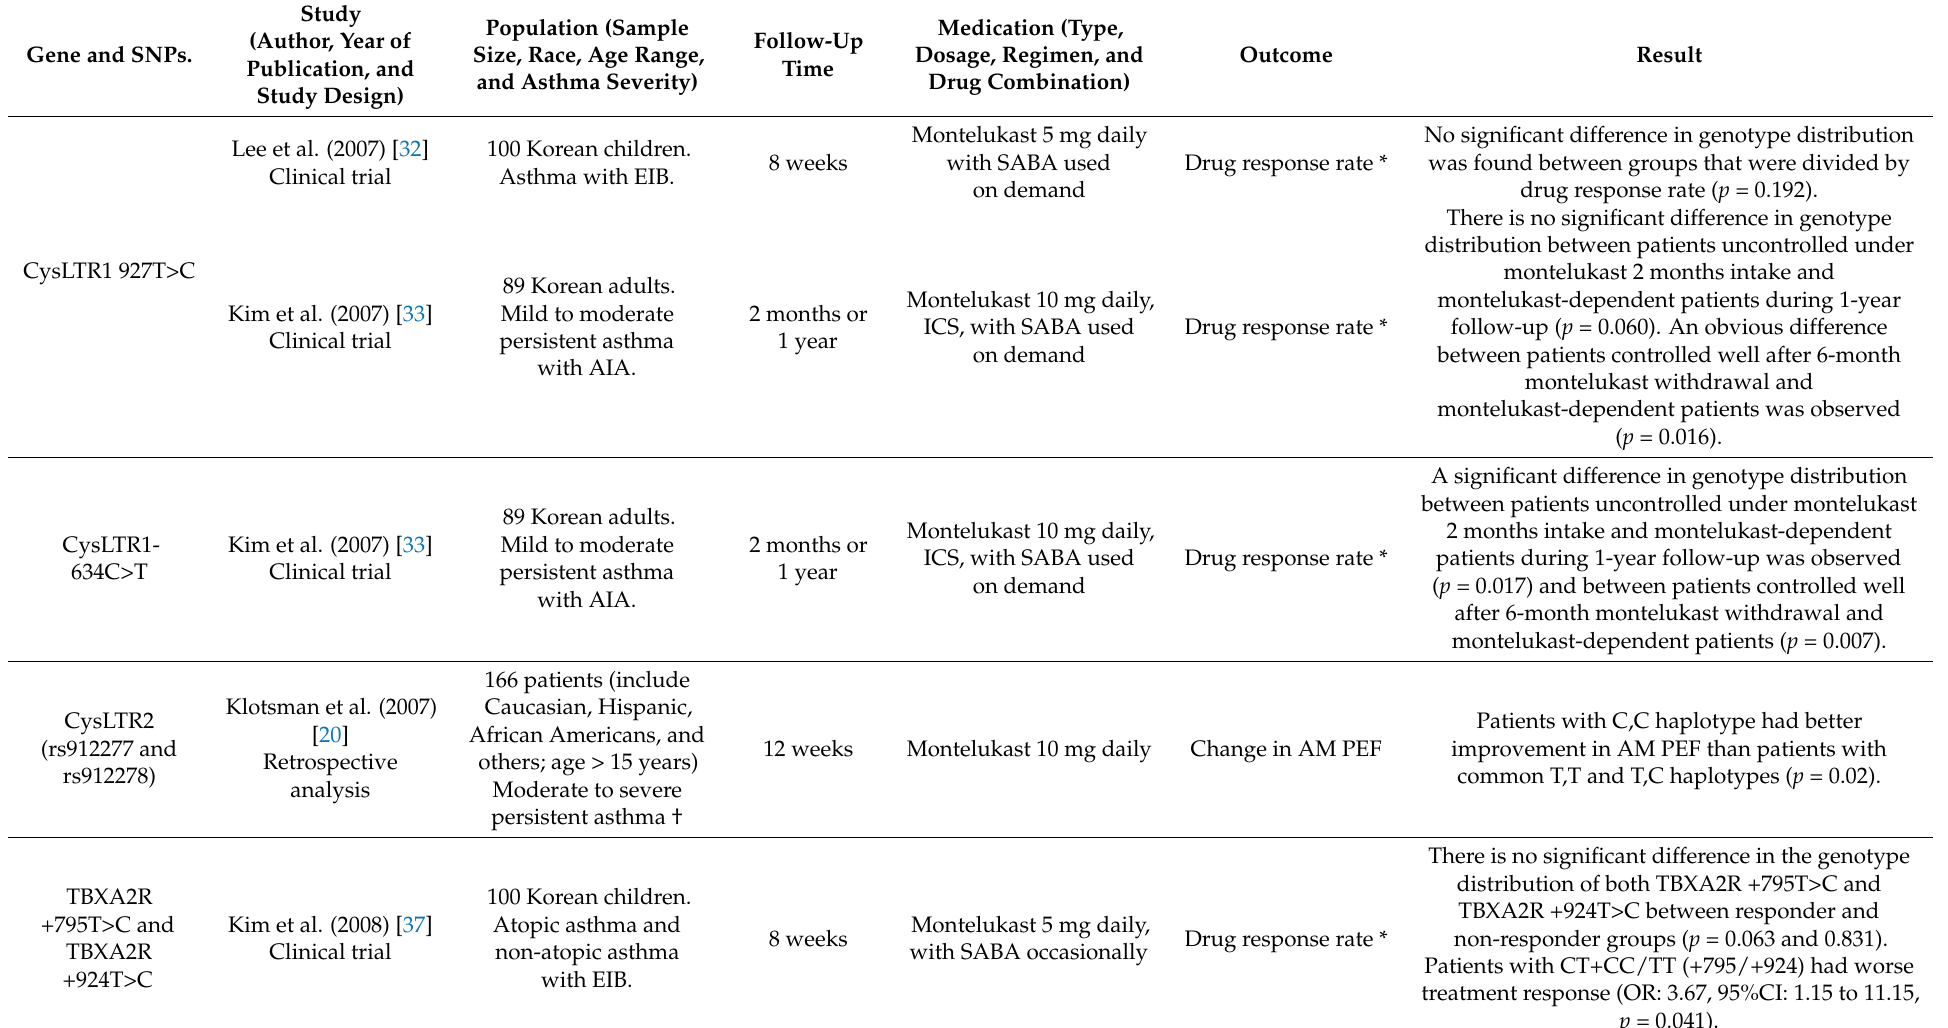
Table 6. The other gene pharmacogenomics studies of response to LTMs.